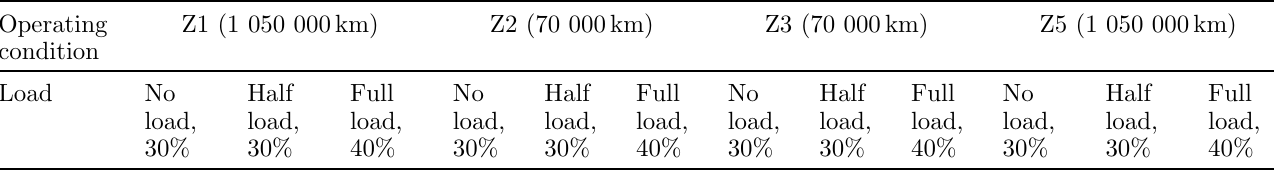
Table 4. Vehicle test plan of durable crystallization condition.